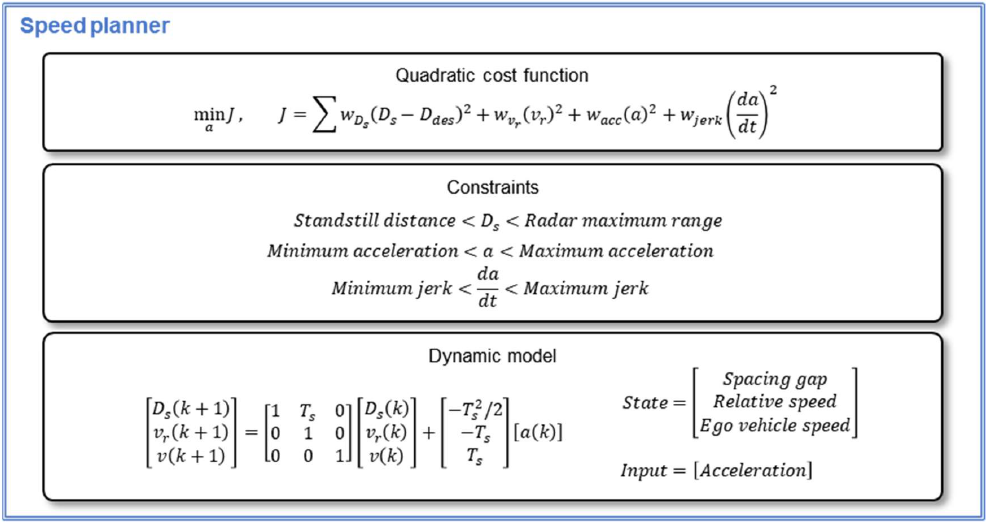
Figure 9. Optimization problem definition of the speed planner.